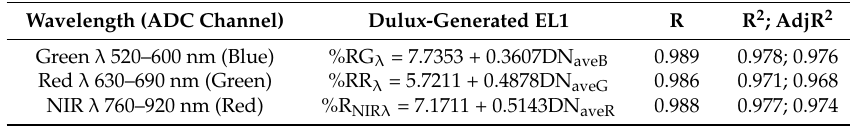
Table 6. OLS equations (EL1) of camera response function per waveband for Dulux samples.